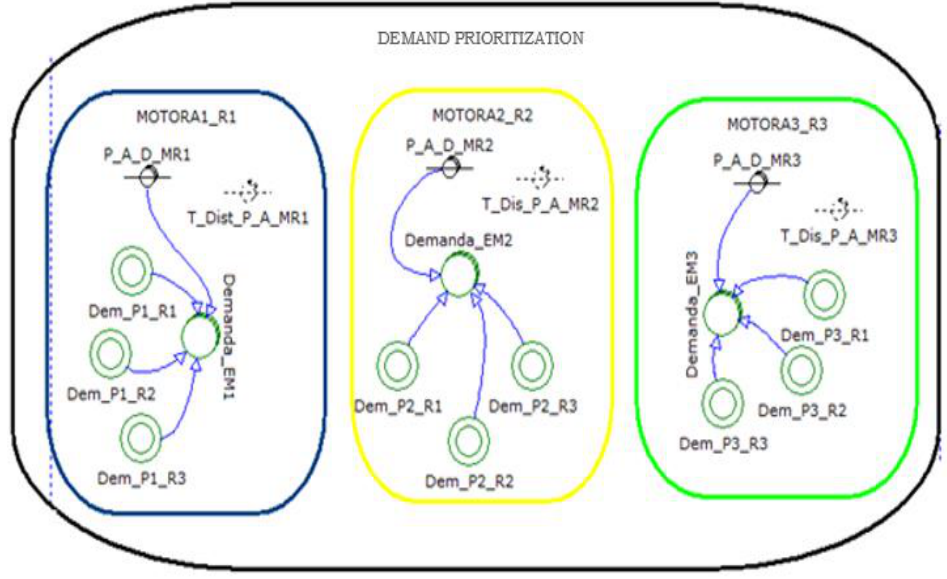
Figure 6. Demand priority policy—scenario 1: own elaboration. Evolution software.